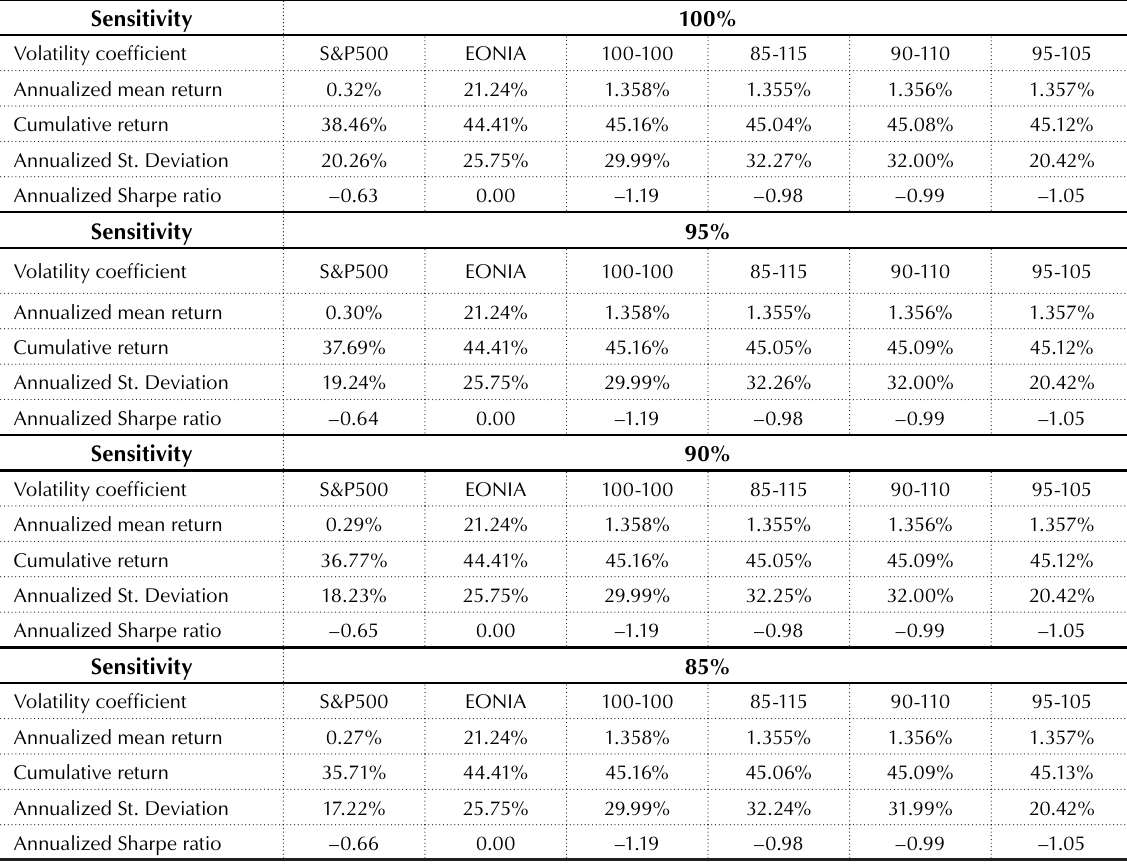
Table 3. Results of sensitivity analysis run for the 6M options based